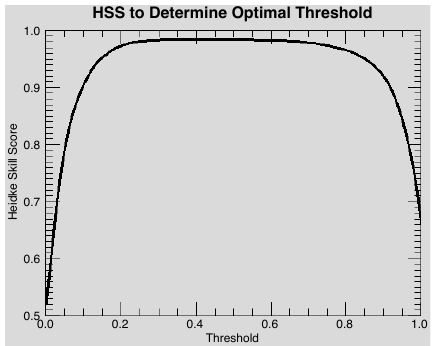
Figure 6. Optimal threshold for SO 2 -rich ash retrieval determined is 0.47 with Heidke skill score of